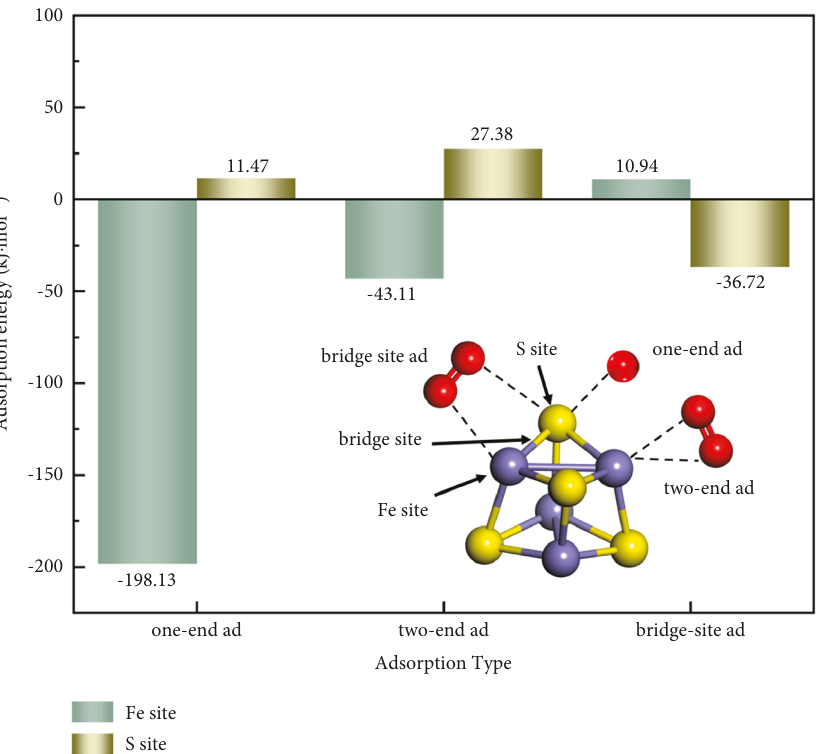
Figure 5: Adsorption energy of O 2 on Fe 4 S 4 clusters. (ad represents